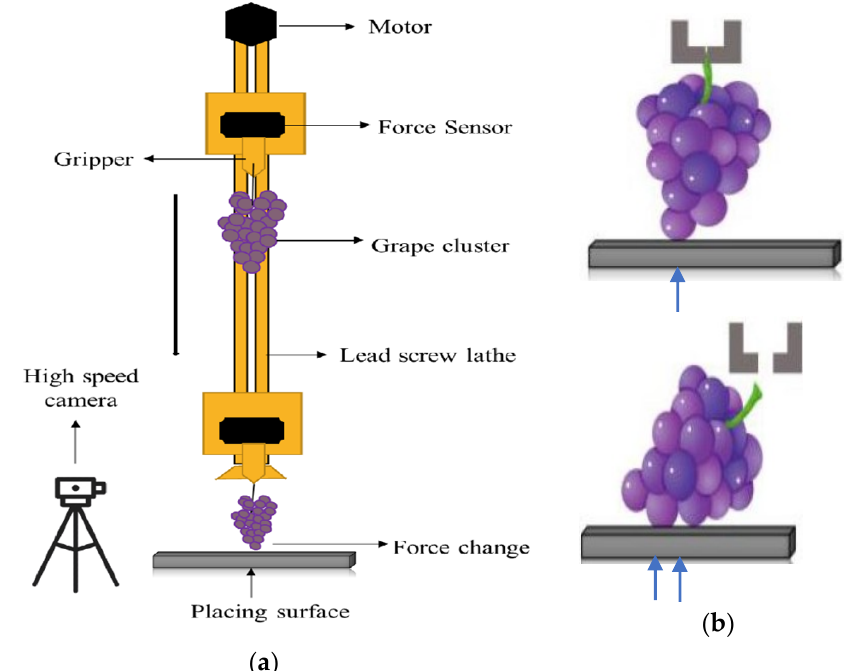
Figure 4. Vertical start and stop transportation placing cycle: ( a ) vertical transportation; ( b ) placing view.